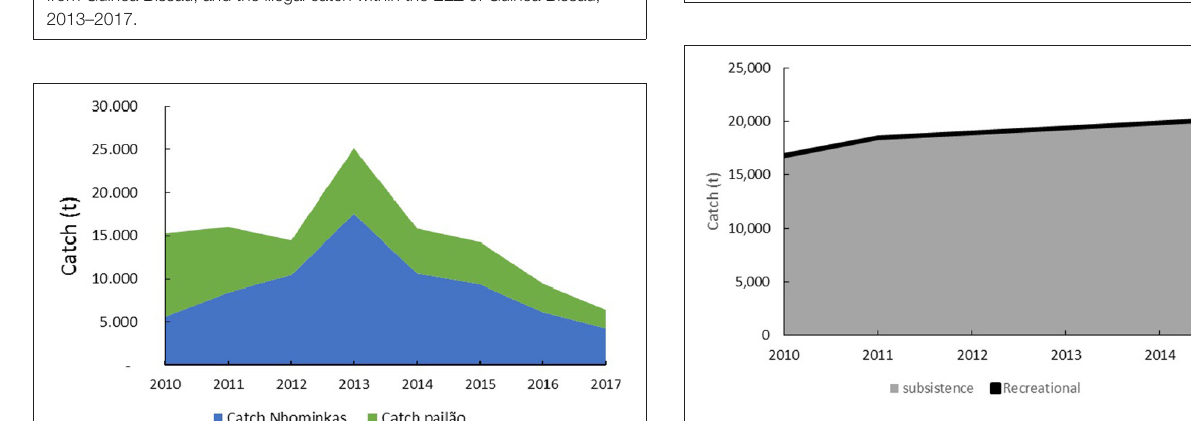
FIGURE 7 | Authorized vs. arrested pirogues in Guinea Bissau, 2012–2015.